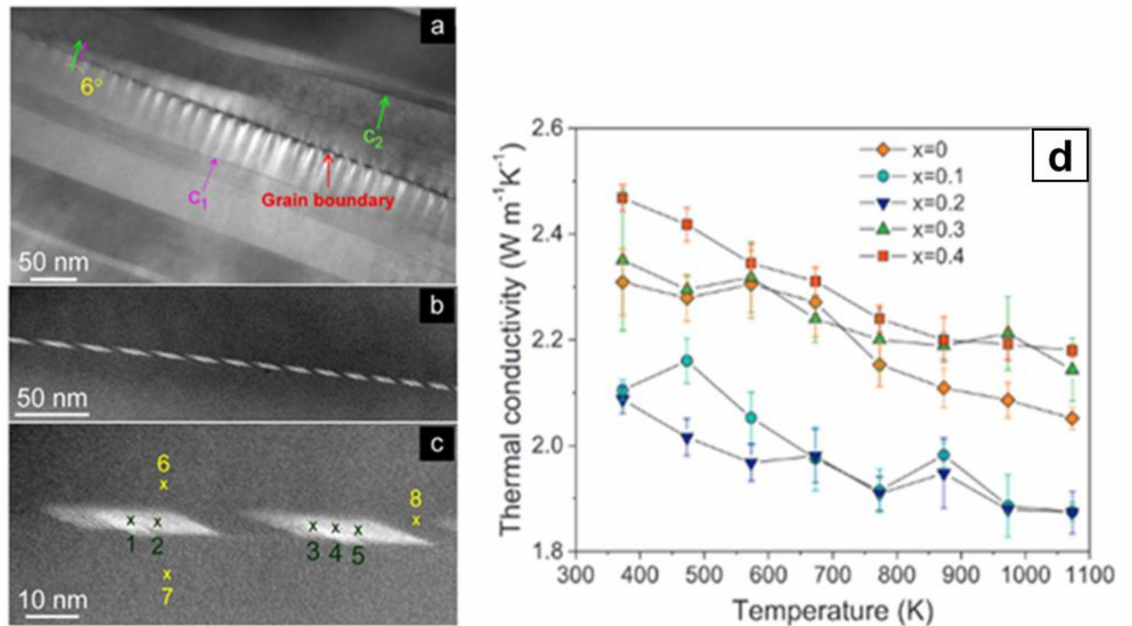
Figure 38. Nanostructure examination of Ca 2.7 Bi 0.3 Co 4 O 9 . ( a ) Low magnification TEM diffraction contrast image shows typical GB and the adjacent two grains. The pink arrow C 1 and the green arrows C 2 indicate the different c-axis orientations of such two neighboring grains and the misorientation angle is about 6 ◦ . ( b ), Low magnification STEM-Z contrast image from the same GB as indicated in ( a ). ( c ) High magnification STEM Z-contrast image of the same GB indicated in b, showing two segregation sites. ( d )Temperature dependence of the thermal conductivity of Ca 3-x Bi x Co 4 O 9 with x = 0, 0.1, 0.2, 0.3 and 0.4 [268]. Figure 38 reprinted from Journal of the European Ceramic Society, 36, Cullen Boyle, Paulo Carvillo, Yun Chen, Ever J. Barbero, DustinMcintyre, Xueyan Song, Grain boundary segregation and thermoelectric performance enhancement of bismuth doped calcium cobaltite, 601–607, Copyright (2015), with permission from